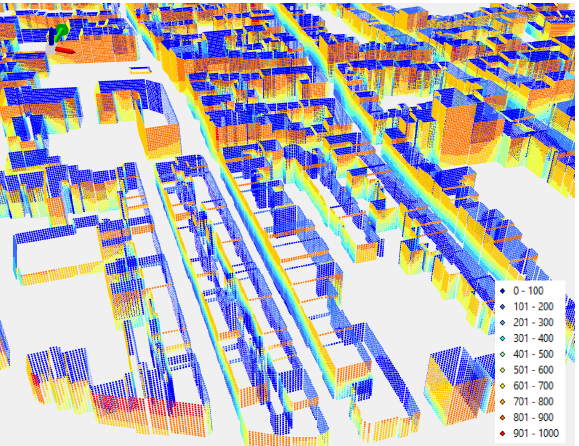
Figure 7. Direct irradiation per hyper-point [kWh/a]